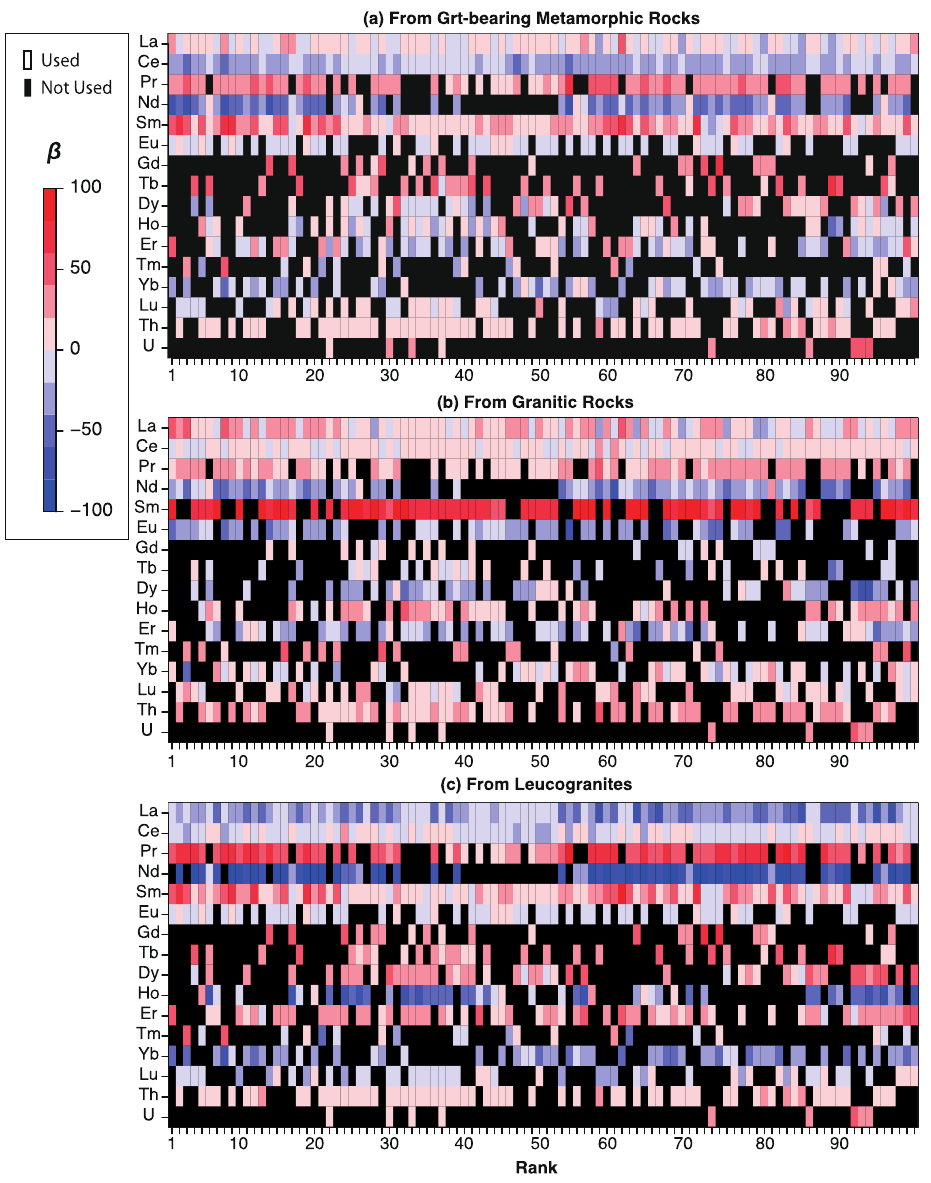
Figure 3. Combinations of elements that were used or not used, as well as regression coefficients (β) for each element and class. The elements that were not used are shown in black, and the regression coefficients are visualized on a color map where red and blue represent positive and negative correlations, respectively.